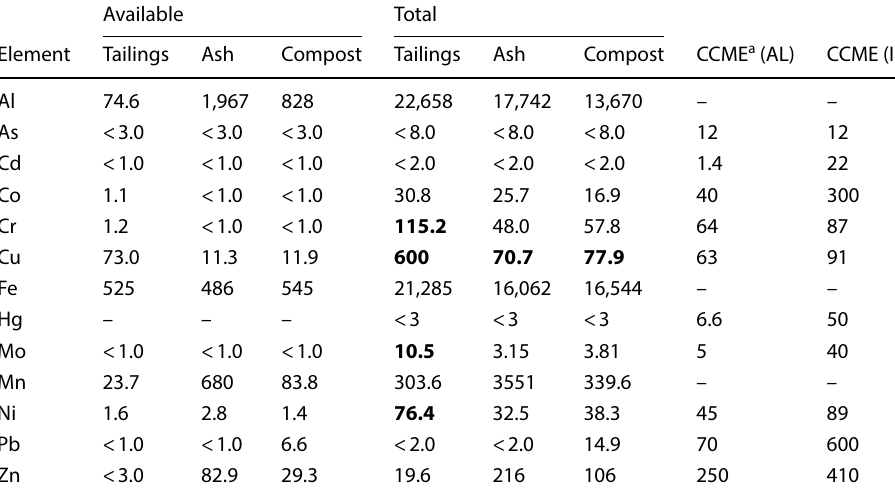
Table 3 Select available and total elemental concentrations (mg kg −1 ) of mine tailings and amendments compared to the Canadian federal soil quality guidelines for agricultural and industrial land use